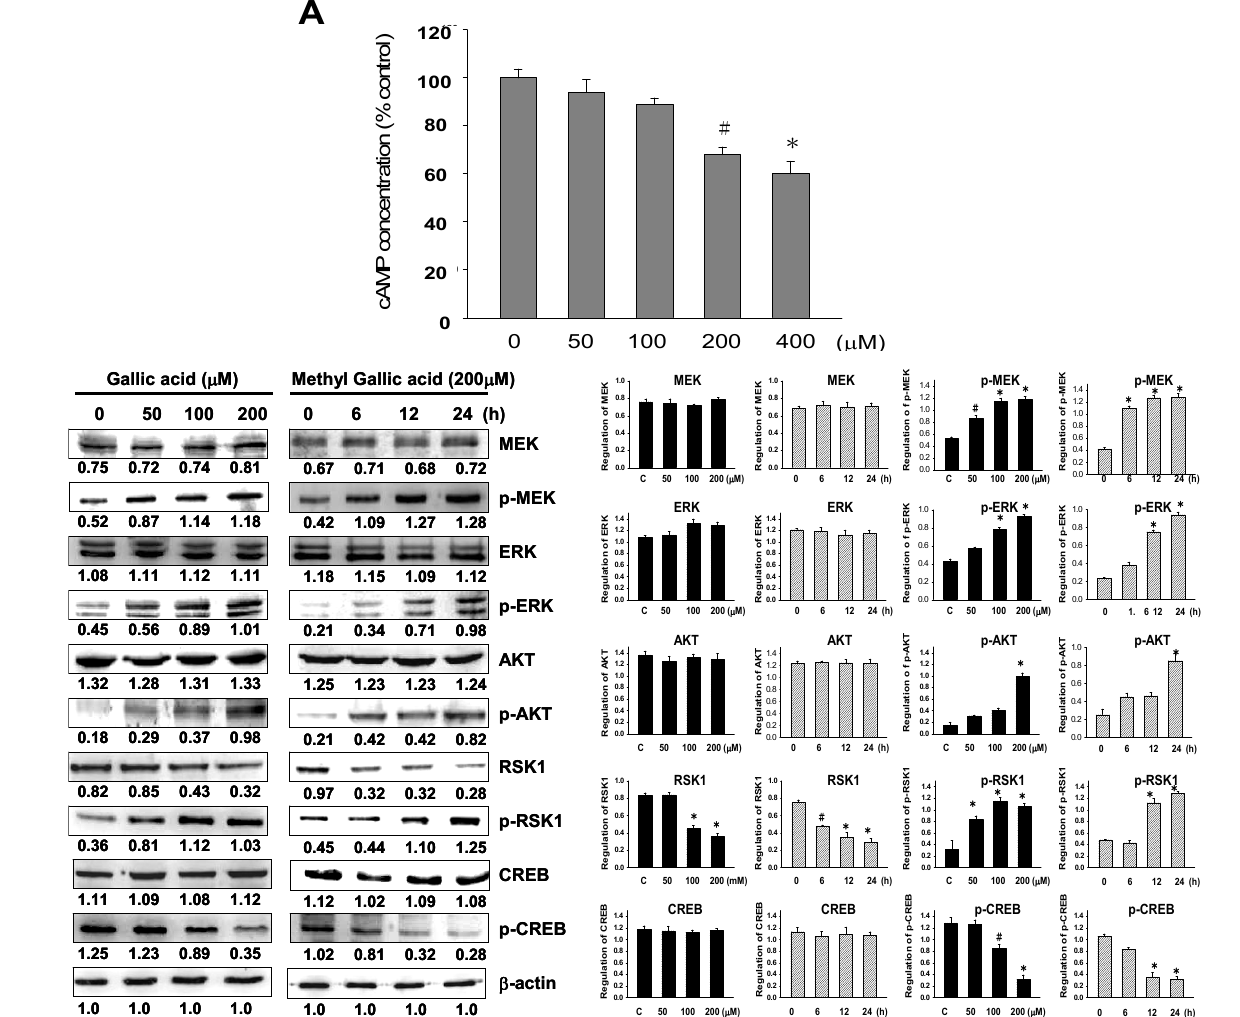
Figure 4. Intracellular cAMP concentration and the expressions of melanogenesis-related proteins in B16F10 melanoma cells with gallic acid treatment. ( A ) Cells were treated with 0~400 µM gallic acid for the indicated durations. Intracellular cAMP levels were measured using a cAMP ELISA kit. The results were representative of three independent experiments ( # p < 0.05, * p < 0.001 compared with the control); ( B ) The western blot assay results showed the changes in p-MEK, MEK, p-ERK, ERK, p-Akt, Akt, p-RSK1, RSK1, p-CREB, and CREB expressions in B16F10 melanoma cells treated with different concentrations of gallic acid (0–200 µM) for 24 h and treated with 200 µM gallic acid at different times. β -Actin was used as the protein loading control. Statistical results represented as Means ± SEM ( n = 3) by ANOVA with the Tukey-Kramer test ( # p < 0.05, * p < 0.001 compared with the